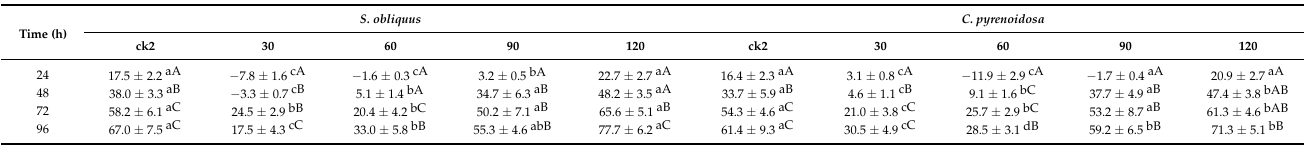
Figure 1. Effects of salicylic acid on the biomass of S. obliquus and C. pyrenoidosa under Cd 2+ stress. Table 1. Salicylic acid (mg/L) on the inhibitory rates (%) of S. obliquus and C. pyrenoidosa under Cd 2+ stress.